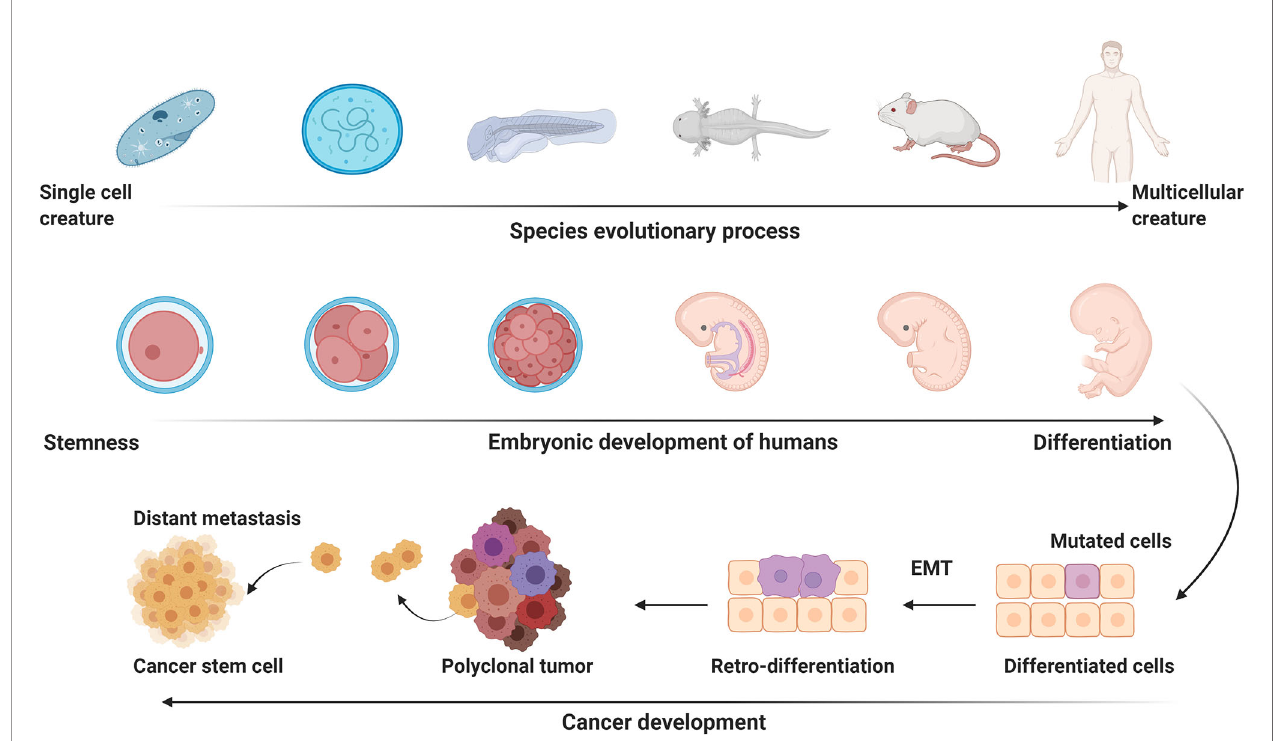
FIGURE 3 | The potential link of carcinogenesis to evolution and development. Embryonic development is the process that a fertilized egg differentiates into various functional and/or structural cells to form different organs and tissues. Embryonic developmental process resembles the process of long-term animal evolution. Carcinogenesis presents a process of reverse evolution and retro-differentiation. EMT, epithelial-mesenchymal transition. This fi gure is created with